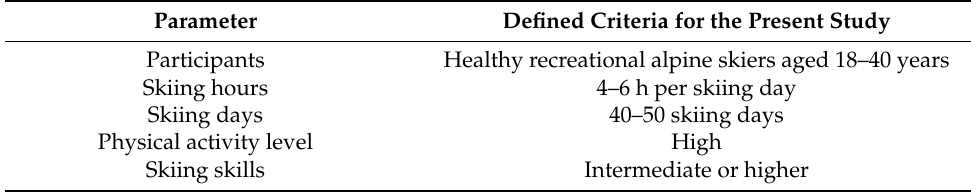
Table 1. The inclusion and exclusion criteria of the study.